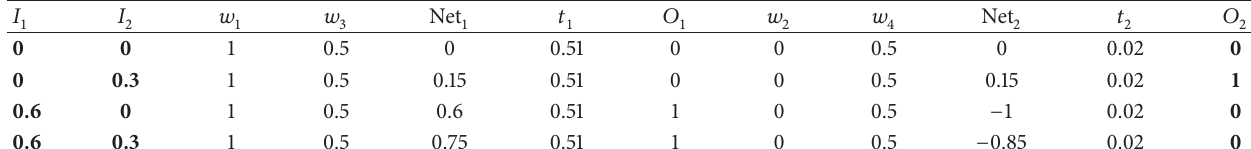
Table 3: Output of CT neuron, 𝑂 2 , for each of the 𝐼 1 , 𝐼 2 input pairs in the standard gate operation calculated from stability weights and thresholds represented in Figure 12(a): Net 1 is obtained applying (2). In this case Net 1 is calculated as Net 1 = 𝑤 1 𝐼 1 +𝑤 3 𝐼 2 for each pair. Neuron 1 output, 𝑂 1 , is equal to 1 when Net 1 is higher than its threshold, 𝑡 1 . Net 2 is calculated having into account neuron 1 inhibitory output: Net 2 = 𝑤